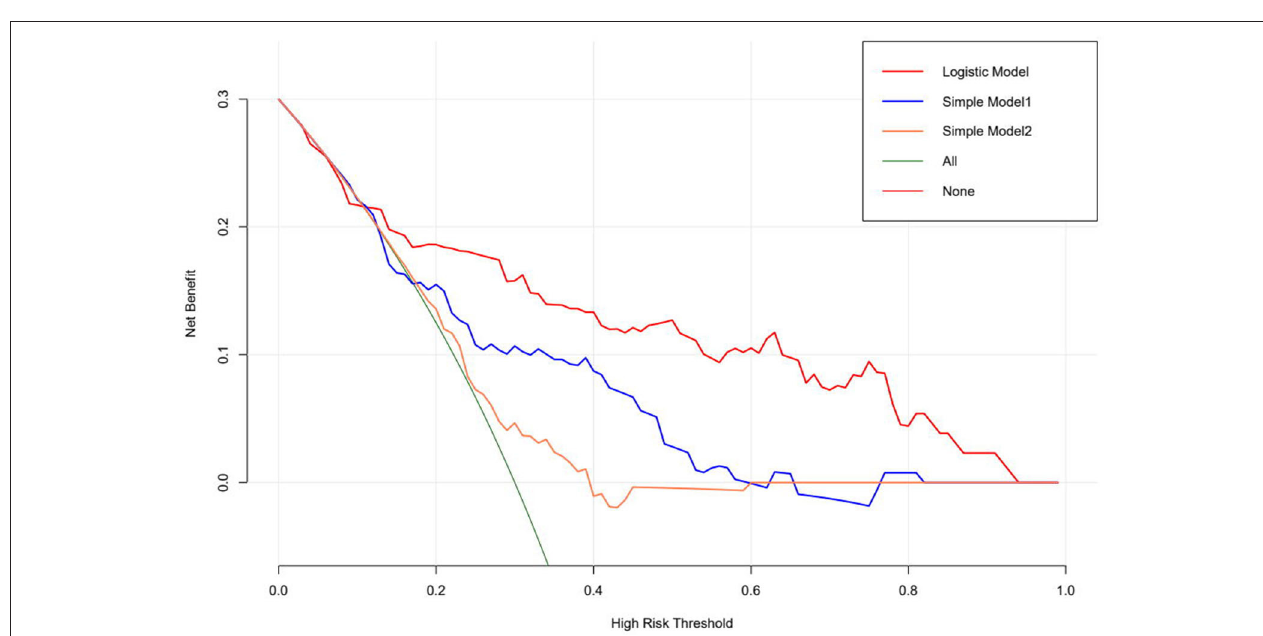
FIGURE 8 | Clinical decision